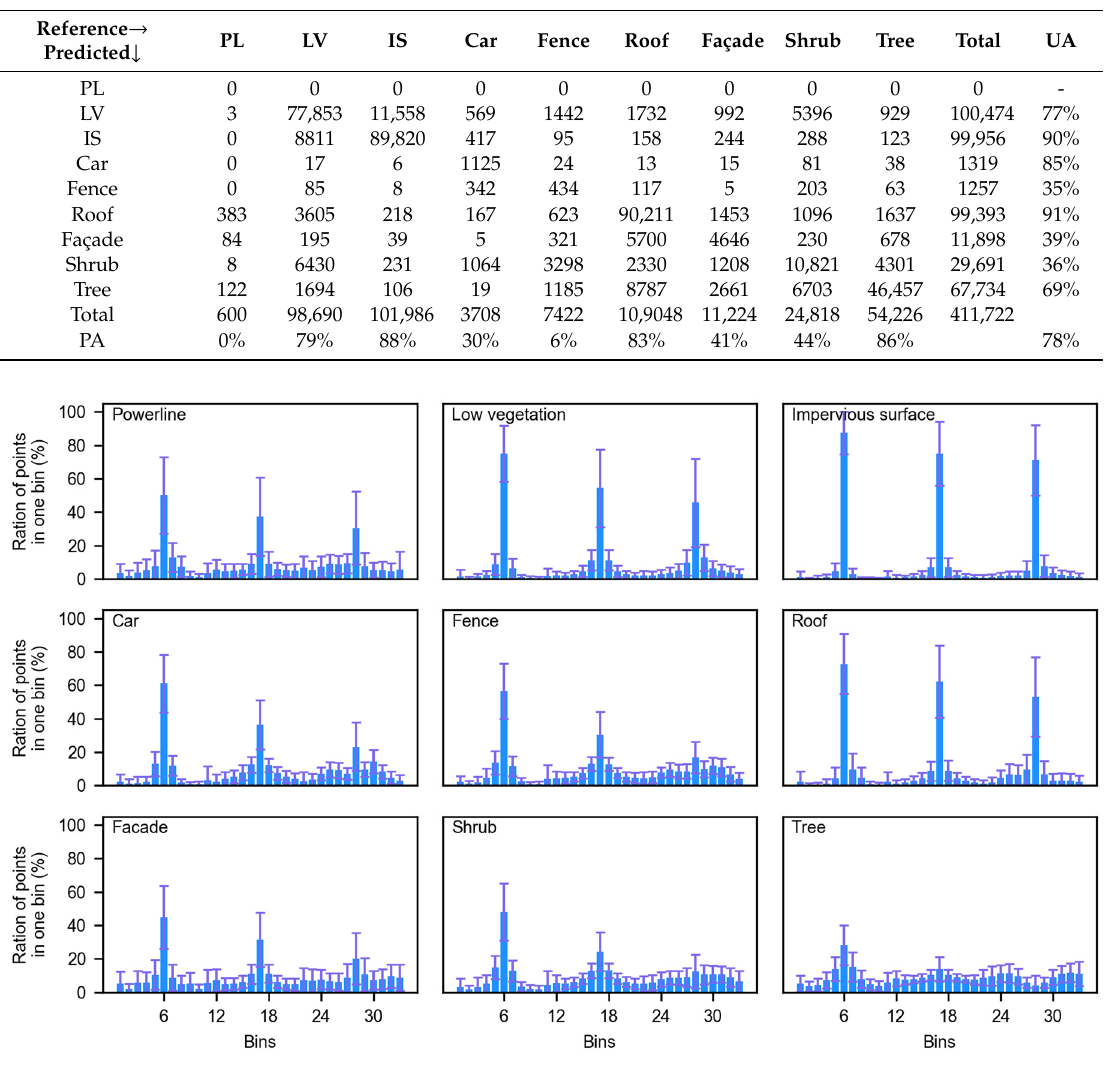
Figure 8. Fast point feature histogram of all geo-objects included in the training data.